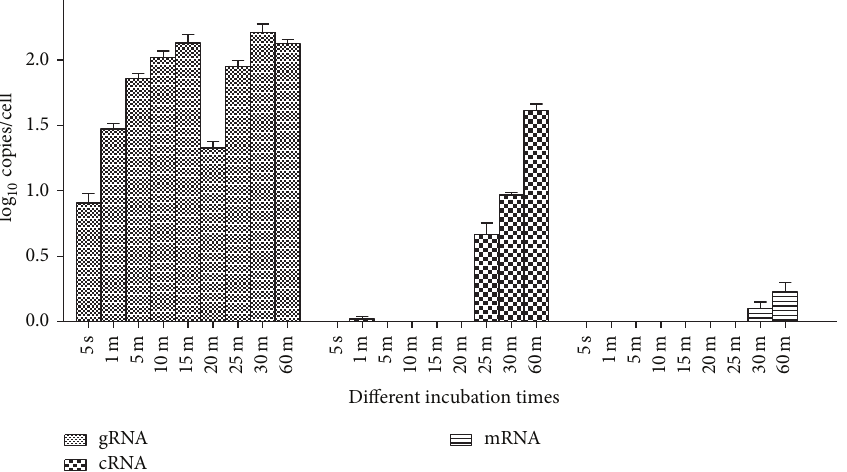
Figure 3: Selection of the optimal adsorption time for La Sota infection. gRNA, cRNA, and mRNA levels were measured at 5s, 1min, 5 min, 10min, 15min, 20 min, 25min, and 30min after DF-1 cells were infected with the La Sota strain at an MOI of 1. The optimal adsorption time was selected as 20 min, since the attachment and detachment of La Sota were balanced at this time